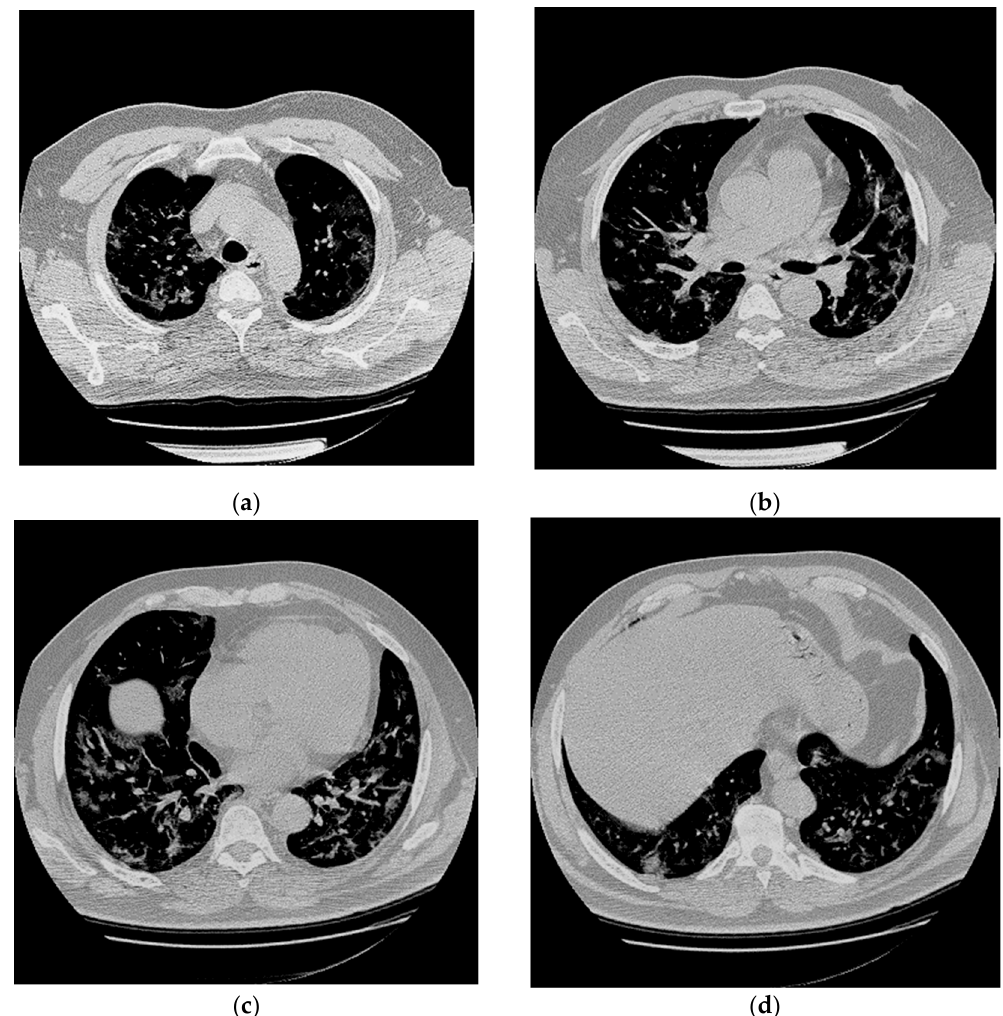
Figure 1. Chest CT abnormalities in a 56-year-old man with positive RT-PCR test results for SARS-CoV-2. ( a – d ) Axial nonenhanced chest CT images (lung window) show diffuse bilateral pulmonary ground-glass opacities and dilated segmental and subsegmental vessels.